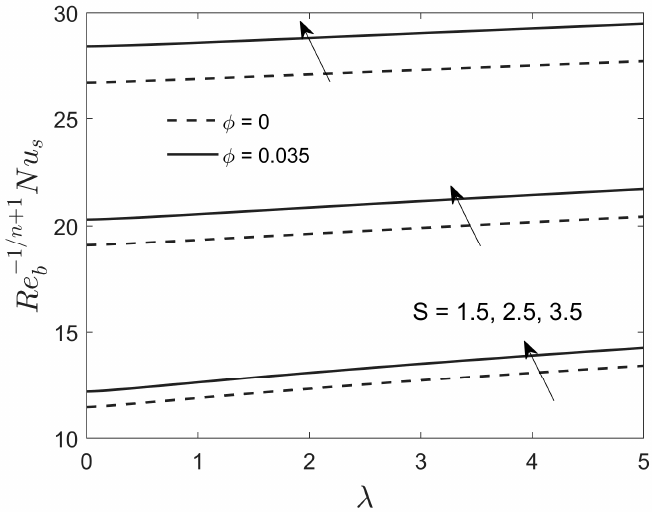
Figure 19. Effect of suction on the Nusselt number against stretching/shrinking.